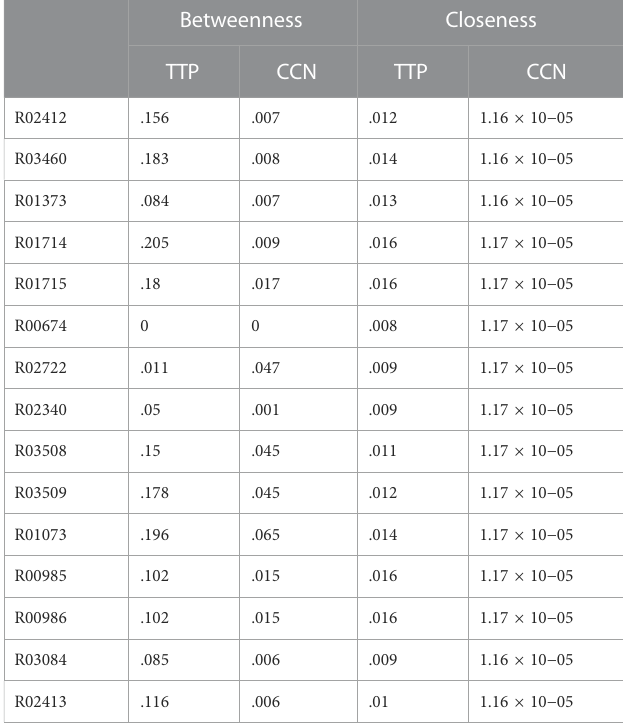
TABLE 2 Average Betweenness and average Closeness values (for 29 organisms) for the nodes in the TTP pathway - in isolation and in the Combined Connected Network (CCN). The standard deviations are not shown as the values are very low.